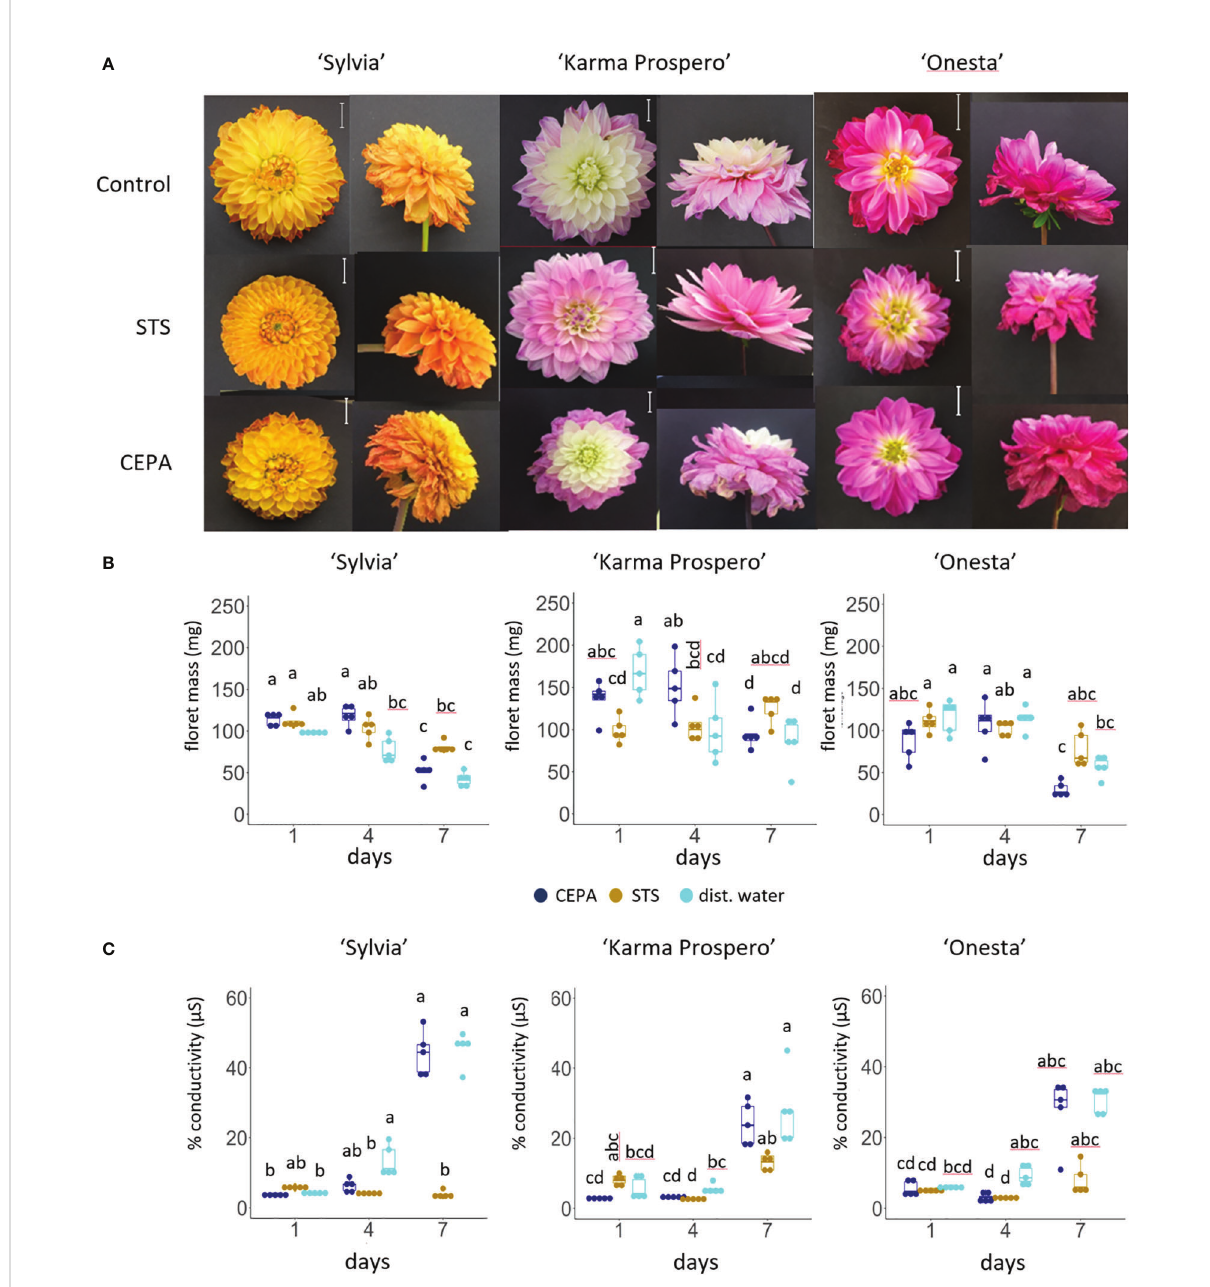
FIGURE 9 Effect of ethylene signalling perturbation on fl oret senescence in dahlia cv.s Sylvia, Karma Prospero and Onesta. Stems were held in distilled water (control), compared to stems treated with a 1 h pulse of 4 mM STS or with 20 µM CEPA. (A) Flower head appearance 7 days after harvesting at Stage III; scale bars represent 20 mm); (B) fl oret mass (C) ion leakage, 1, 4 and 7 days after cutting stage (n=5). Different letters indicate signi fi cant differences p < 0.05, based on a 2-way ANOVA followed by a Tukey ’ s test or a Kruskall Wallis test followed by a Dunn ’ s post hoc test if the data did not fi t the normality and equal variance criteria